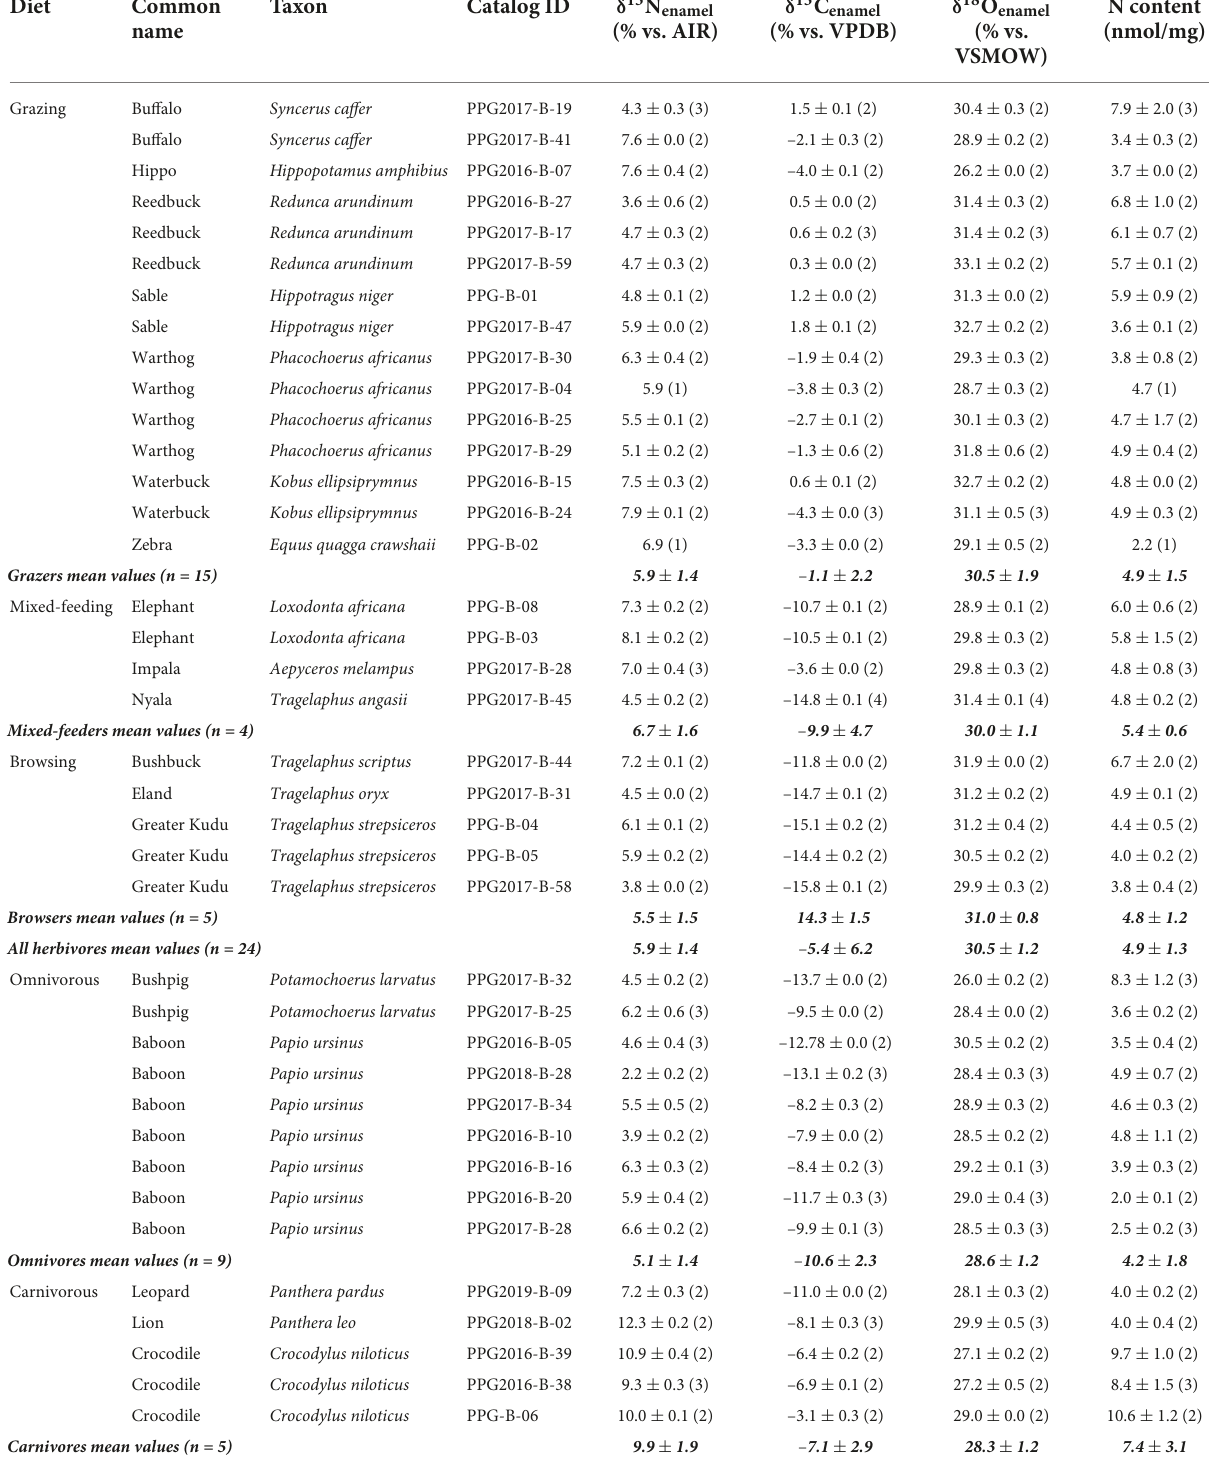
TABLE 1 List of all 38 analyzed specimens including diet, common and Latin name, catalog ID, and stable nitrogen, carbon, and oxygen values in % and nitrogen content. Mean values for each dietary group are shown in bold.